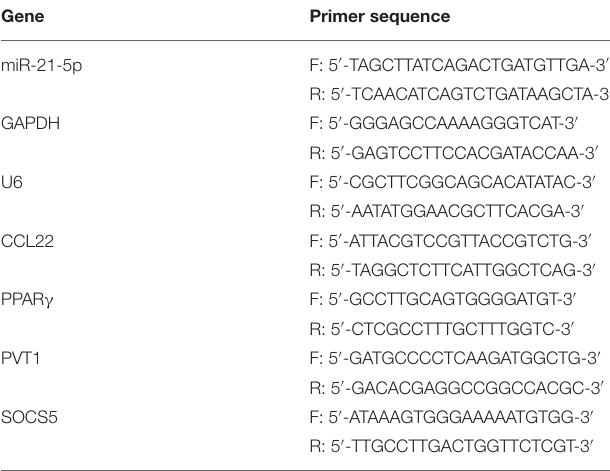
TABLE 1 | Primer sequences of